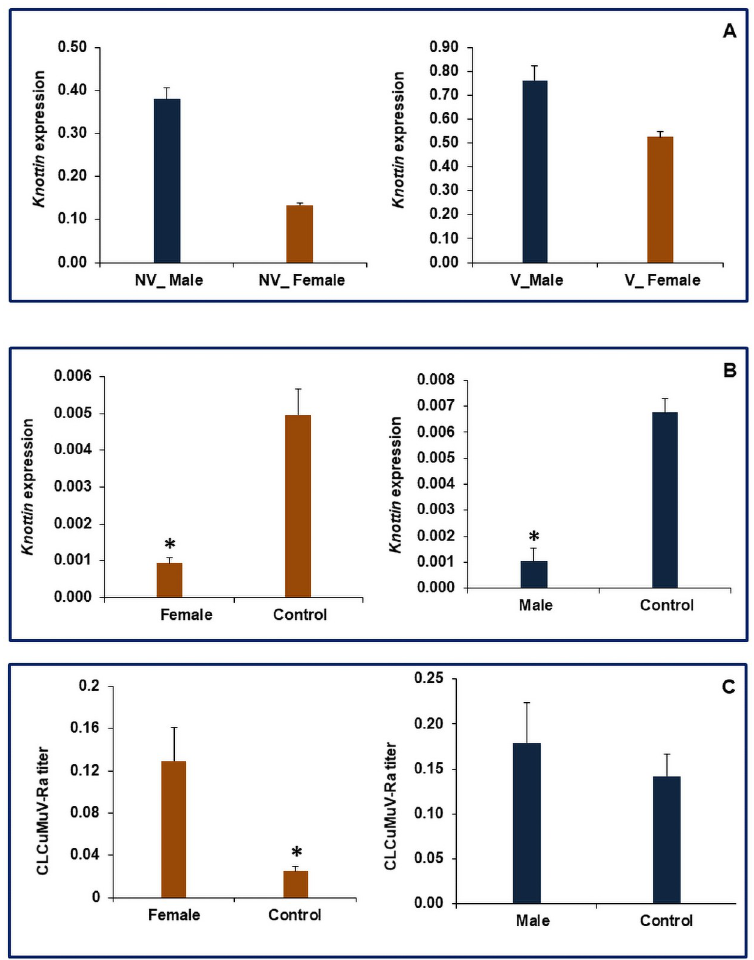
Fig 6. Relative expression of Knottin in B . tabaci , A. Non-viruliferous and Viruliferous whiteflies, B. dsRNA fed female and male whiteflies; C. Relative titerof Cotton leaf curl Multan virus -Rajasthanin Knottin knockdown viruliferous female and male whiteflies. The expression level was normalized with β -tubulin as housekeeping gene. Error bars represent the standard deviation (n = 3) and � represents significant differences in expression (P � 0.05, Student’s